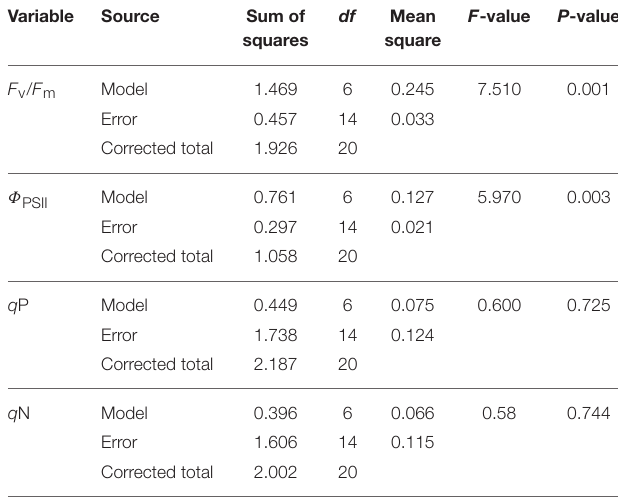
TABLE 4 | Variance analysis of the chlorophyll fluorescence parameters F v /F m (Maximum photochemical quantum yield of PSII), Φ PSII (effective photochemical quantum yield of PSII), q P (photochemical quenching), and q N (Non-photochemical quenching) of stem among seven studied